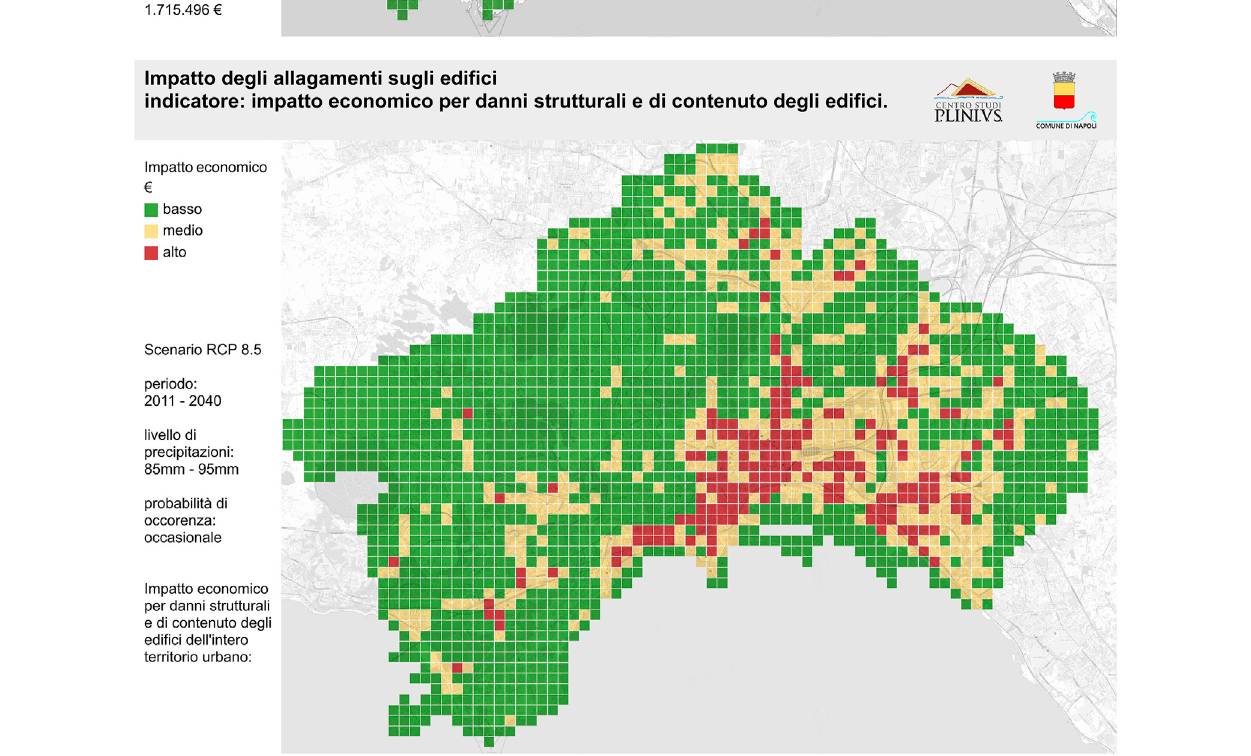
Frontiers in Environmental Science |